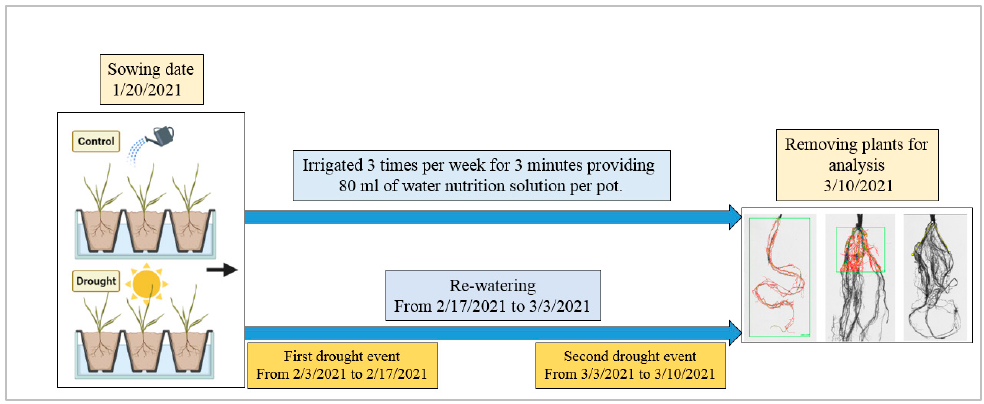
Figure 1. Experimental model.